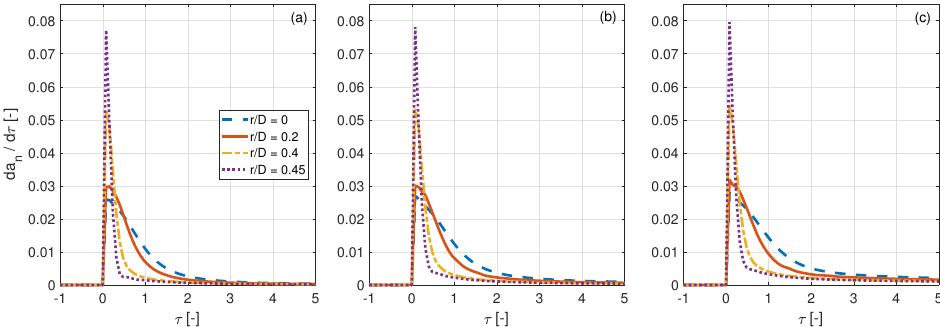
Figure 13. Time derivative of a n at different radial positions from CFD model, when step ∆ C T = +0.1, θ az = 180 deg, ( a ) Base C T = 0.2, ( b ) C T = 0.6, ( c ) C T = 0.8.